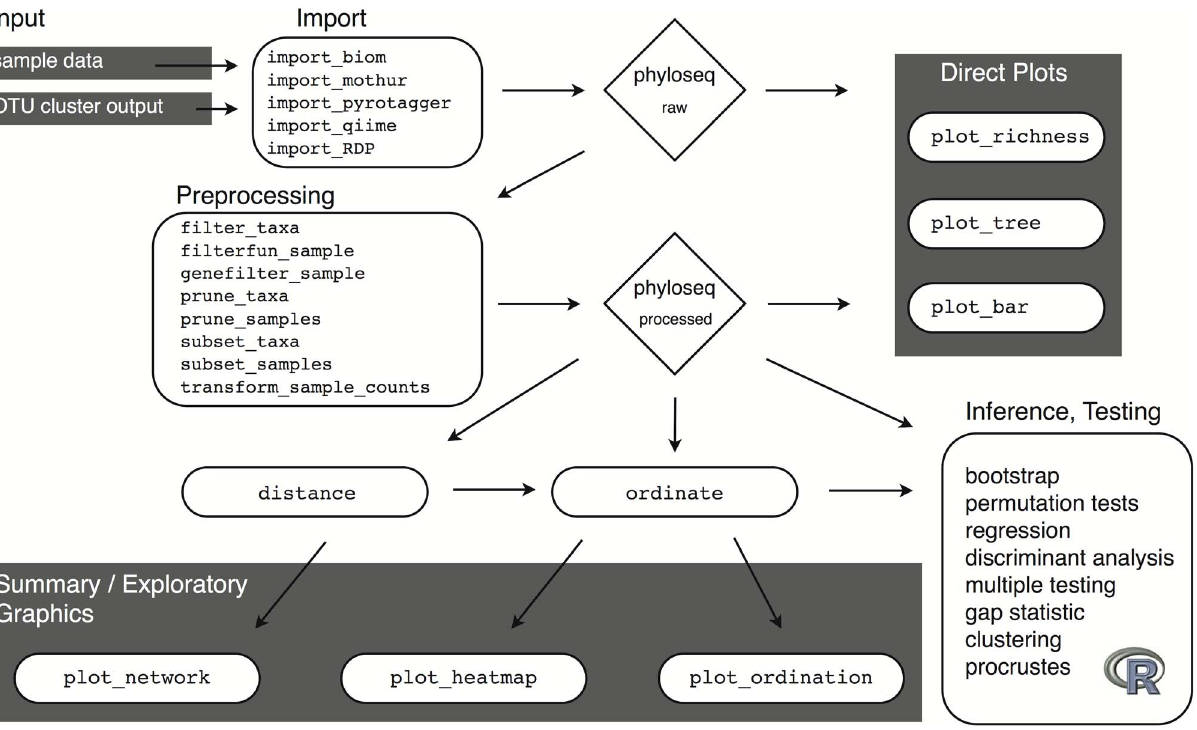
Figure 2. Analysis workflow using phyloseq. The workflow starts with the results of OTU clustering and independently-measured sample data (Input, top left), and ends at various analytic procedures available in R for inference and validation. In between are key functions for preprocessing and graphics. Rounded rectangles and diamond shapes represent functions and data objects, respectively, further described in Figure 3.